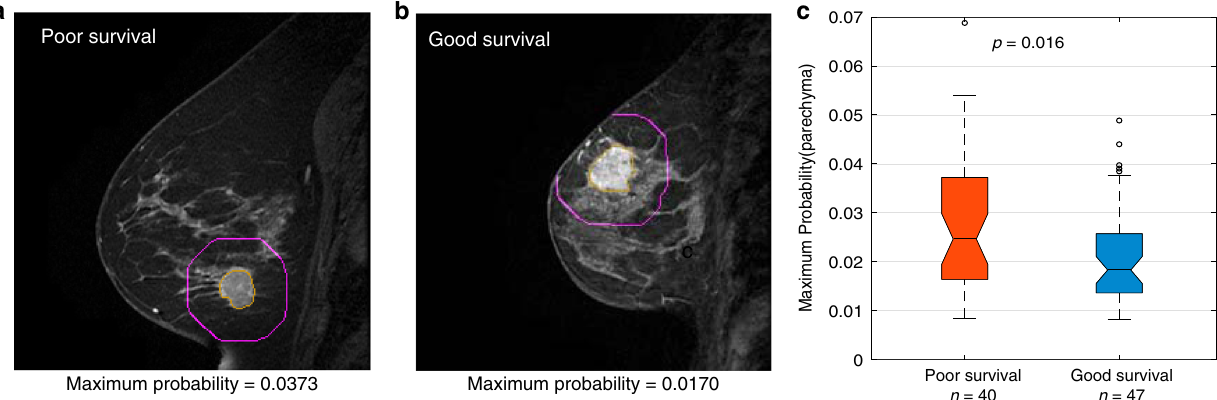
Fig. 6 Imaging features used to predict the outcomes of patients with different breast tumour subclone compositions. The regions of interest (ROIs) for the parenchyma region (purple line) and the tumour are shown. Examples of patients in the poor-survival group ( a ) with a feature (maximum probability) value of 0.0373 and in the good-survival group ( b ) with a feature value of 0.0170. c The feature values are signi fi cantly different between the good-survival ( n = 47) and poor-survival ( n = 40) groups (two-tailed Student ’ s t test; t = − 2.45, df = 85, p = 0.016). In the boxplot, centre line represents median; box limits indicate upper and lower quartiles; whiskers represent 1.5 × interquartile range and points are outliers. Source data are provided as a Source data fi le.